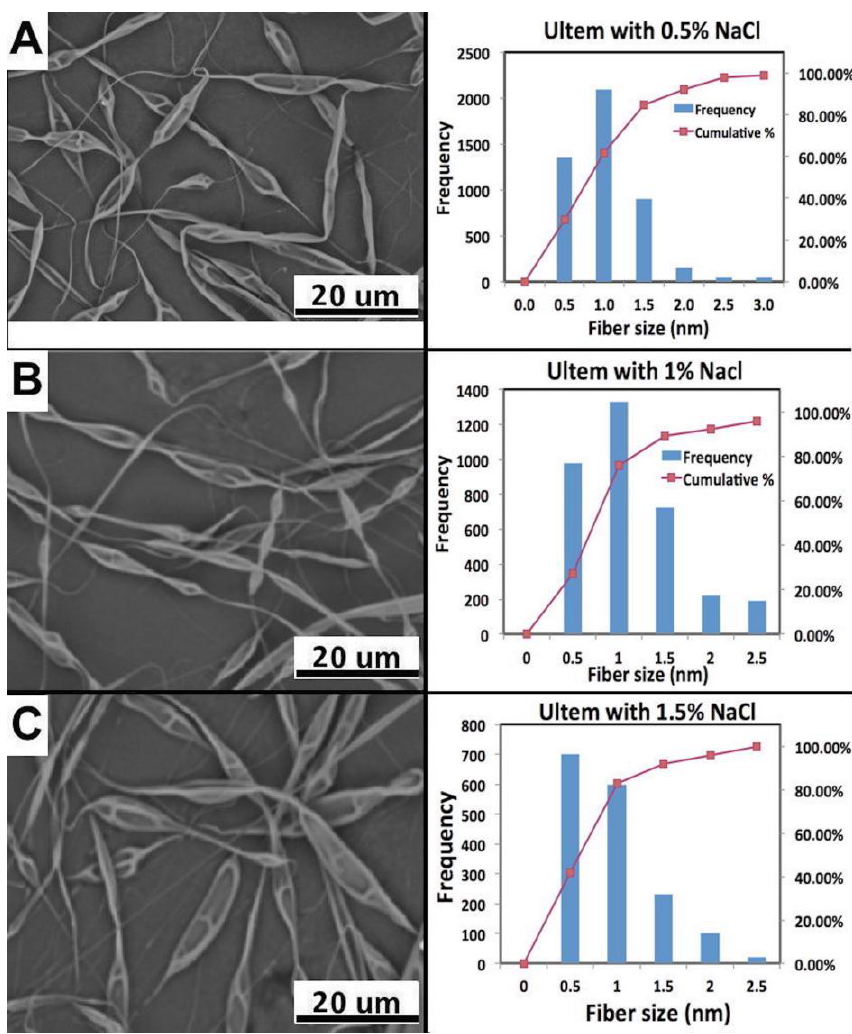
Figure 5. SEM images of 14 wt. % PEI and ( A ) 0.5 wt. % NaCl, ( B ), 1 wt. % NaCl, ( C ) 1.5 wt. % NaCl, salt addition electrospun fibers at 20 kV/20 cm and 10 µL/min.